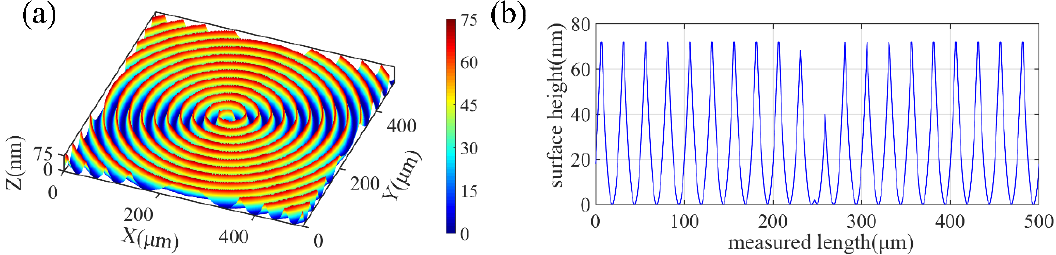
Figure 5. One of the typical simulated surfaces under an ideal condition. Here, ( a ) is a typical 3D surface topography and ( b ) is a cross-sectional profile from ( a ).